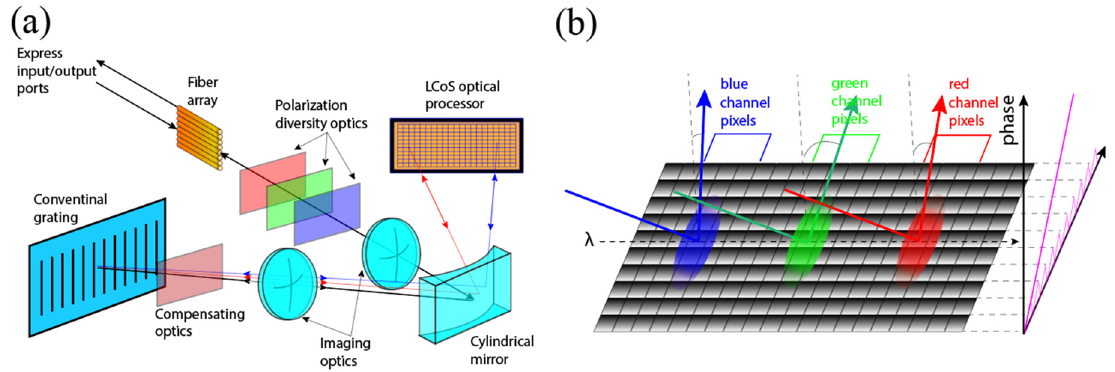
Figure 2. ( a ) The optical system of WSS; ( b ) illustration of beam steering principle using an LCoS phase modulator.